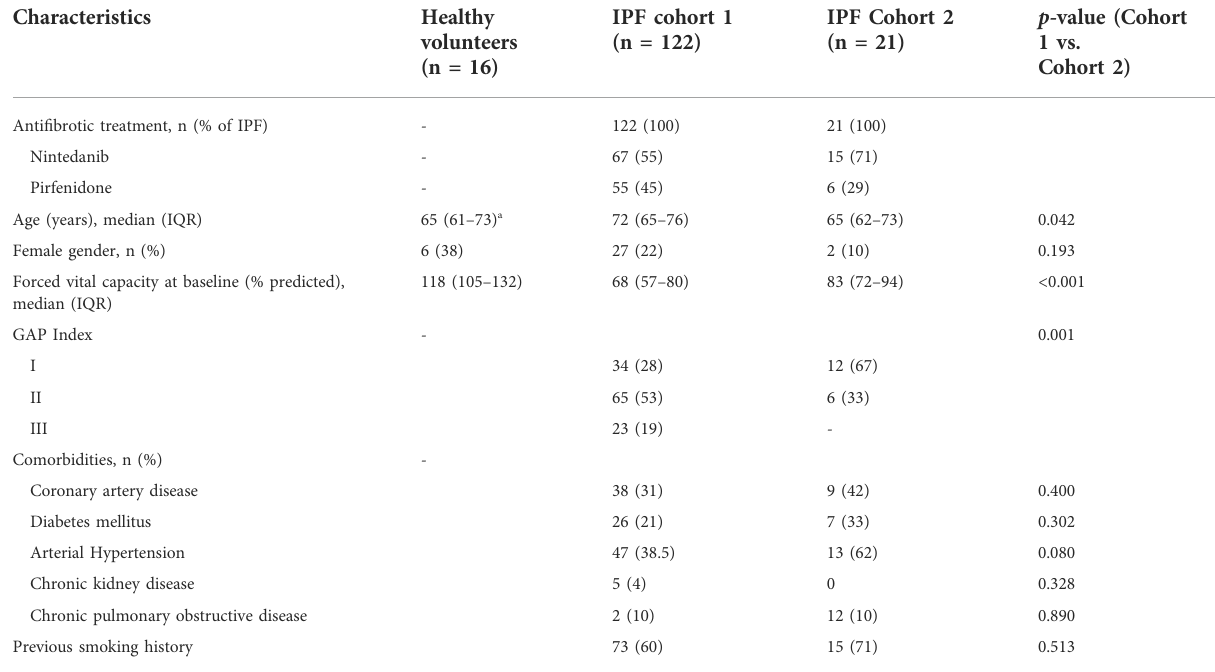
TABLE 1 Demographics of study cohorts at start of anti fi brotic therapy.